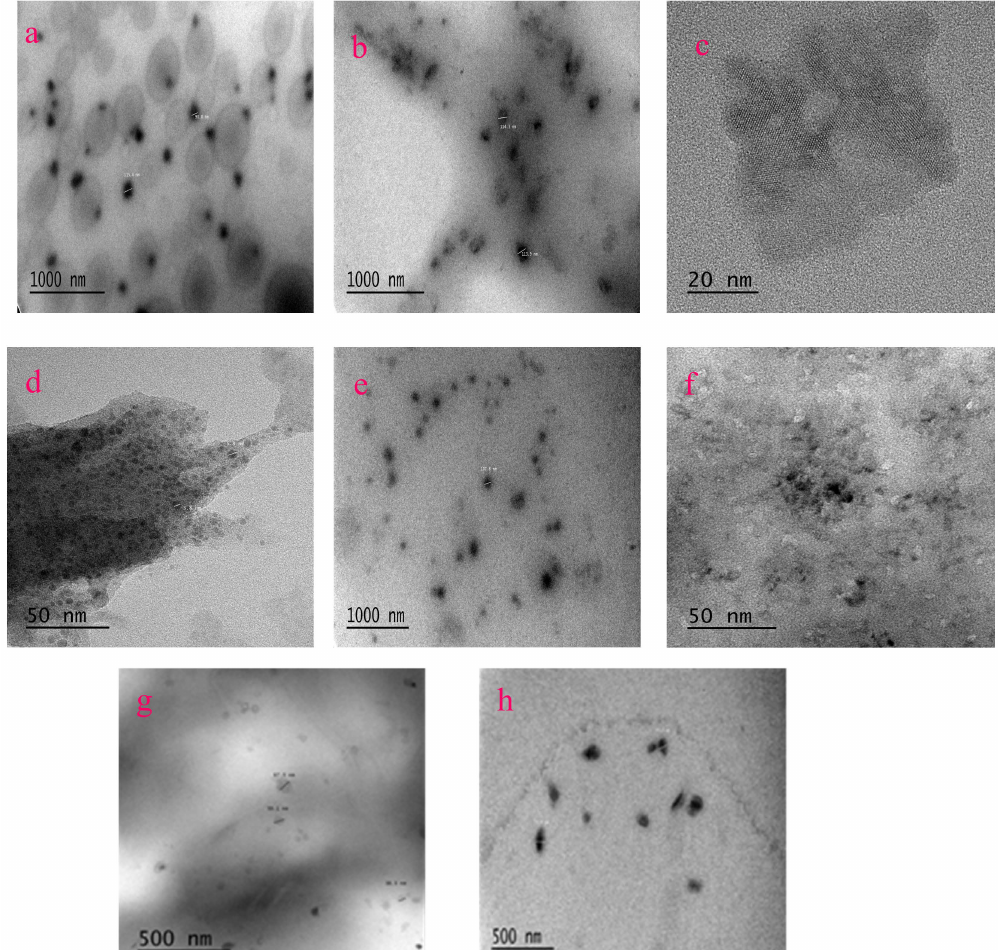
Figure 1. TEM images of Sm–Me (Me = Fe, Ga, Mn, Na, Nb, W, Cu, and Al) metal organic compound nanoparticles: ( a ) Sm–Fe; ( b ) Sm–Ga; ( c ) Sm–Mn; ( d ) Sm–Na; ( e ) Sm–Nb; ( f ) Sm–W; ( g ) Sm–Cu; ( h )